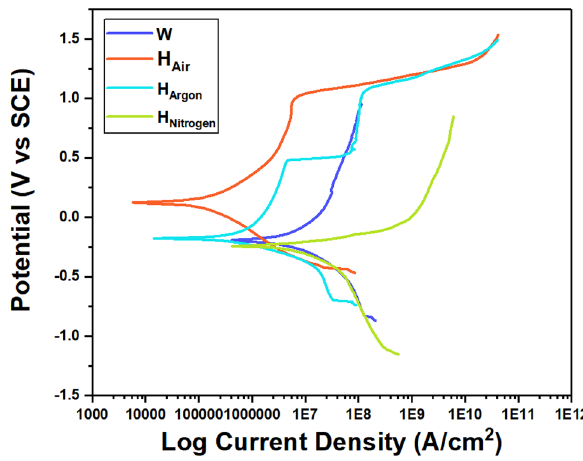
Figure 21. Polarization curves of weld zone of (W, H Air , H Argon , H Nitrogen ) samples.